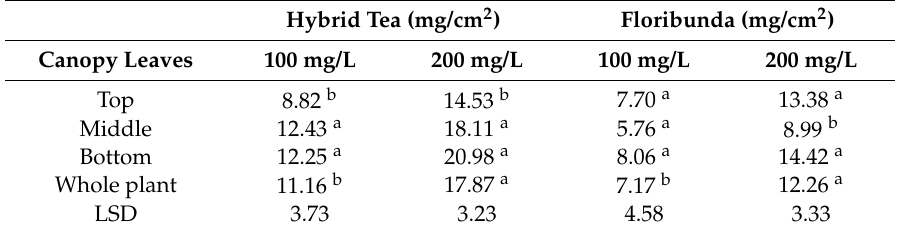
Table 1. The actual dosage (mg/cm 2 ) of two benzyladenine (BA) formulations (100 & 200 mg/L) after application to two rose varieties as determined by using filter paper.